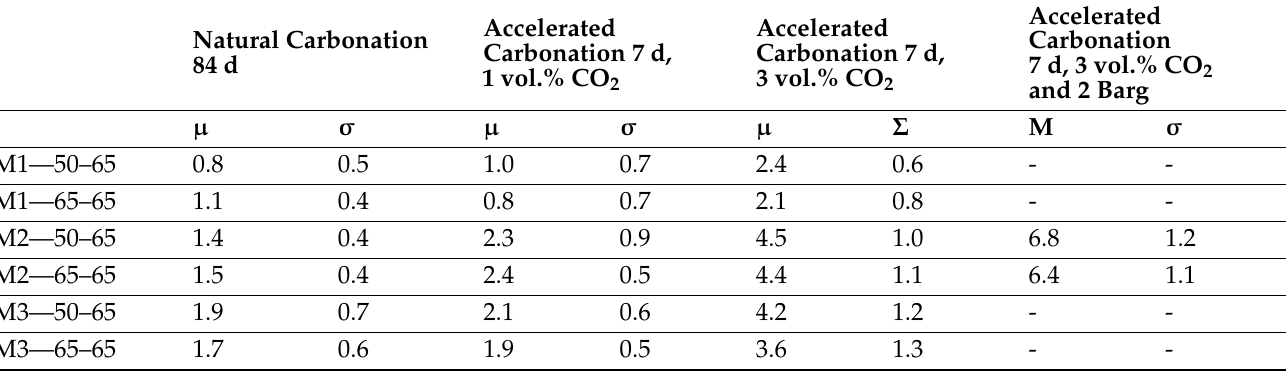
Table 6. Carbonation depth of M1, M2 and M3 under different CO 2 exposures (RH during accelerated carbonation: